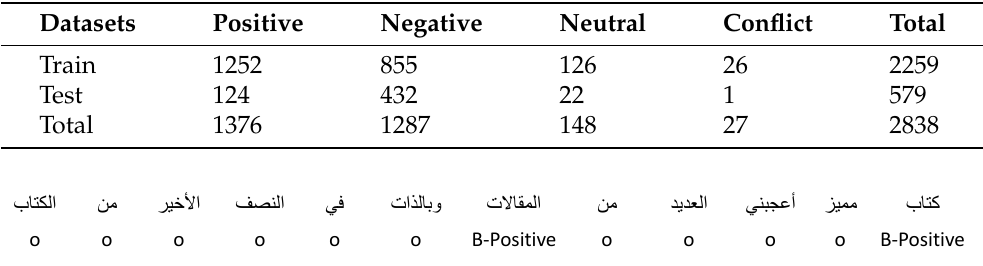
Figure 2. Example of a sentence from HAAD dataset.